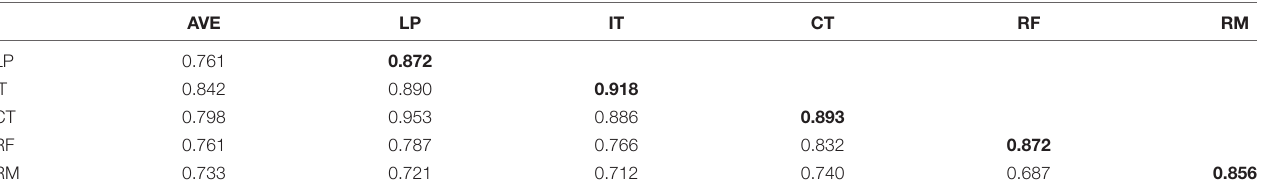
TABLE 3 | Validity analysis of measurement model.